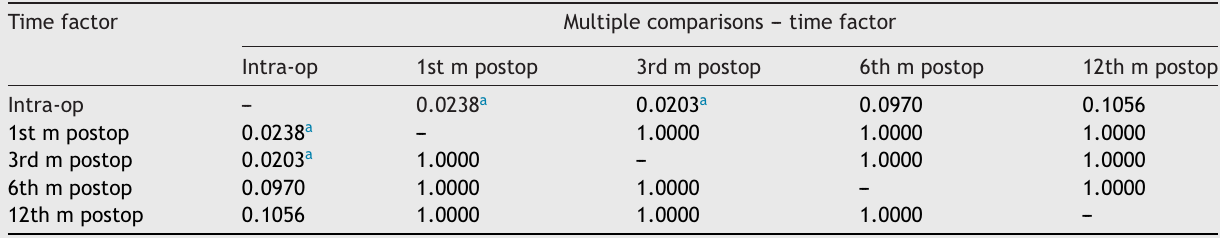
Multiple comparisons for the time of follow-up